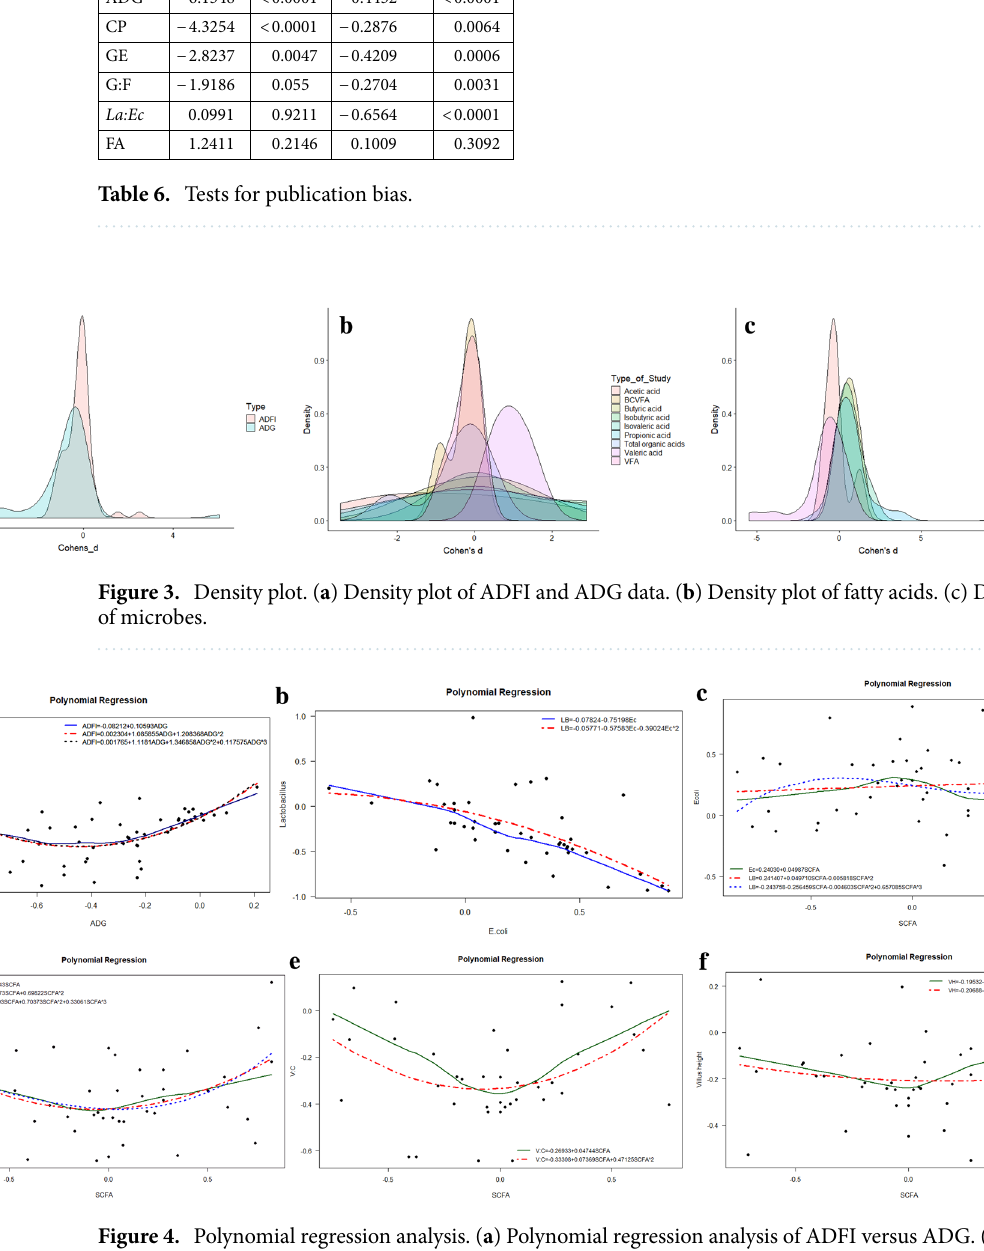
Figure 4. Polynomial regression analysis. ( a ) Polynomial regression analysis of ADFI versus ADG. ( b ) Polynomial regression analysis of Lactobacillus versus E.coli ( c ) Polynomial regression analysis of E.coli versus fatty acids. ( d ) Polynomial regression analysis of Lactobacillus versu Fatty acids. ( e ) Polynomial regression analysis of V:C versus fatty acids. ( f ) Polynomial regression analysis of Villus height versus fatty acids. ADFI: Average daily feed intake; ADG: Average daily gain; LB: Lactobacillus ; Ec: Escherichia coli ; V/VH: Villus height, C: Crypt depth, FA/SCFA: fatty